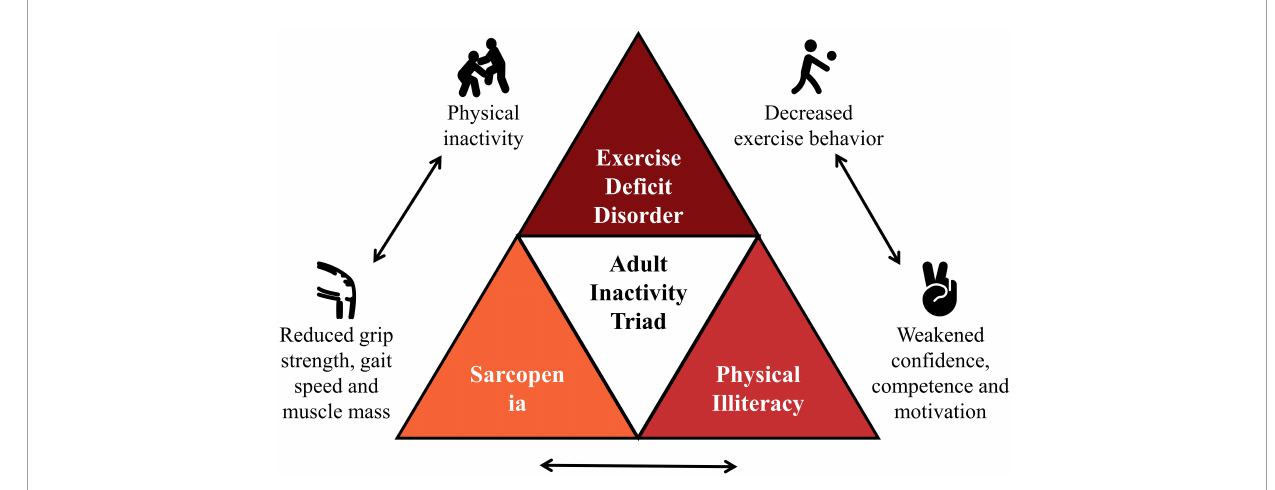
FIGURE1 The “adult inactivity triad” in chronic kidney disease (CKD). Adapted from Wilkinson et al. (14).